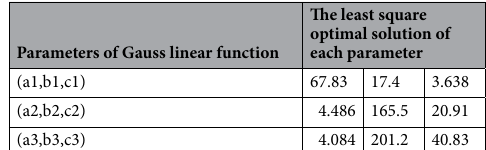
The least square optimal solution of